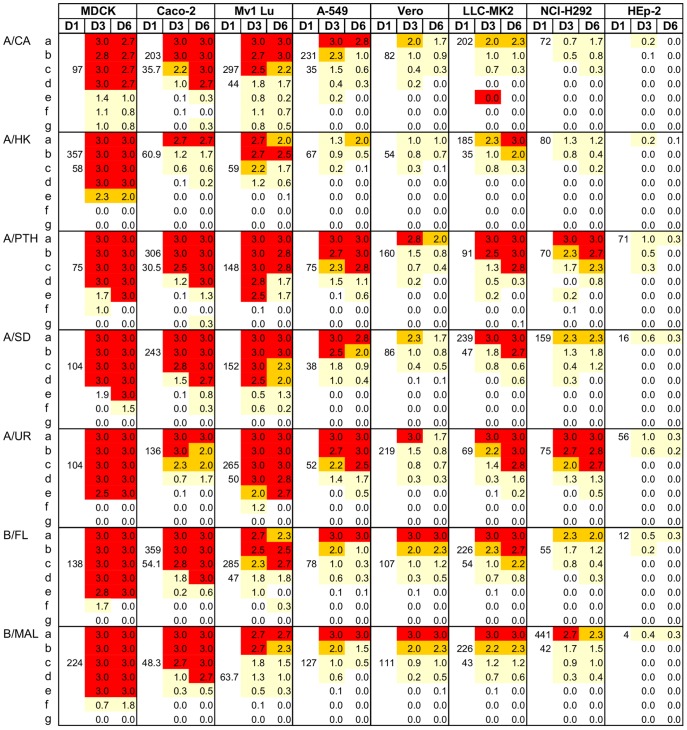
Composite analysis of replication and spread of seven different influenza types/subtypes in eight different cells.The A549, Caco-2, HEp-2, LLC-MK2, MDCK, Mv1 Lu, NCI-H292, and Vero cells were infected with the same serial 10-fold dilutions (for virus nomenclature see Materials and Methods) to limiting dilution starting at approximately 10,000 FFU per well (FFU based on infectivity in MDCK cells). Composite data are for FFA foci number on Day 1 (D1) and HA expression at Day 3 (D3) and 6 (D6) post-infection. The results represent the average of 3 independent assays. Culture medium was supplemented with TPCK-Trypsin at 0.5 µg/ml. The FFA foci number is the average number of foci over 3 independent assays and indicates the row used for counting foci. Each row (a-g) represents a 10-fold dilution of virus and rows below the foci count would contain progressively fewer infectious particles until the dilution limit is reached. Rows above the countable foci had too many foci to accurately count and row H was used as blank. Average subjective scores (see Materials and Methods) were determined (values of 0, 0.5, 1, 2, and 3) and color coded as white (0 no HA expression), cream (0.1–1.9), orange (2–2.4) and red (2.5–3.0).